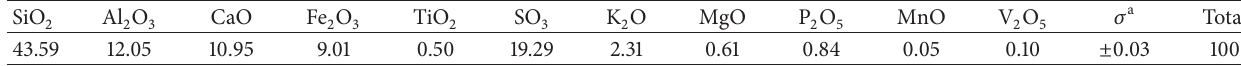
Table 1: Elemental analysis of the raw coal gangue (wt.%).